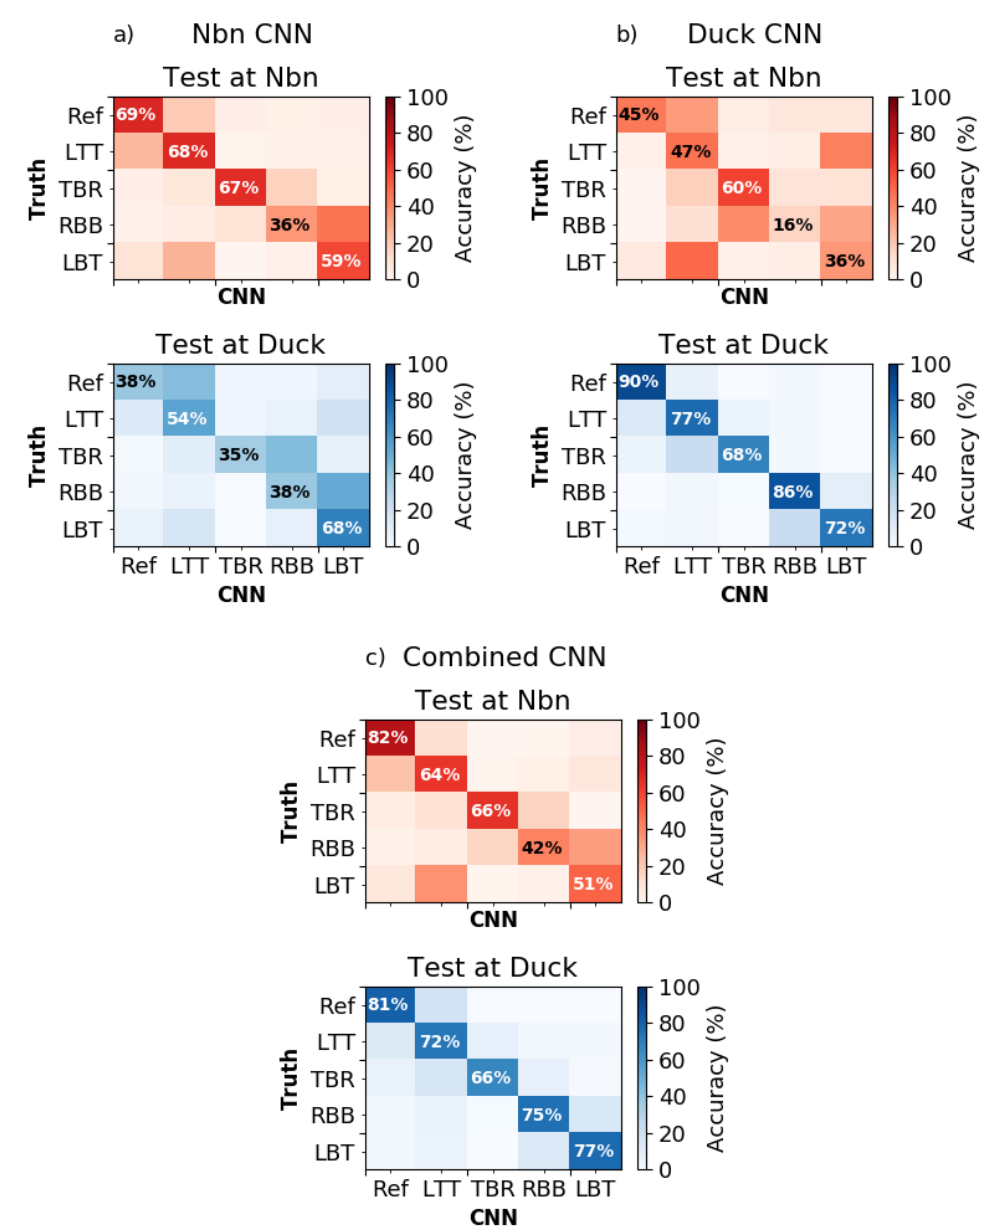
Figure 6. Confusion table results from the Nbn-CNN, Duck-CNN and combined-CNN (panels ( a – c ), respectively). Top panel (red) shows results for tests at Nbn, and bottom panel (blue) shows results from tests at Duck. For each matrix, the label provided by the CNN is counted in the columns, and the true label is counted in the rows. Per-state accuracies are within the